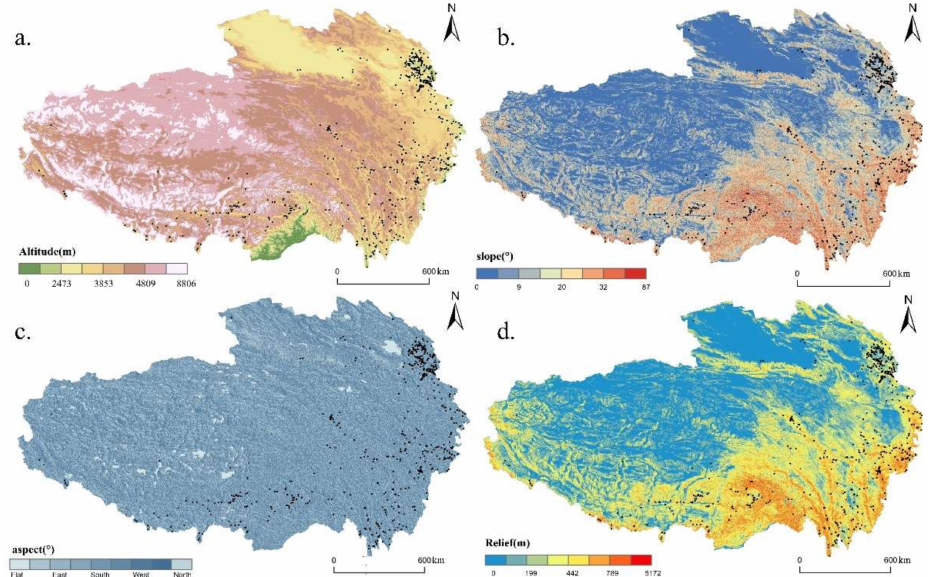
Figure 6. Spatial distribution of RT villages coupled with topographic: ( a ) altitude; ( b ) slope; ( c ) aspect; ( d ) relief.